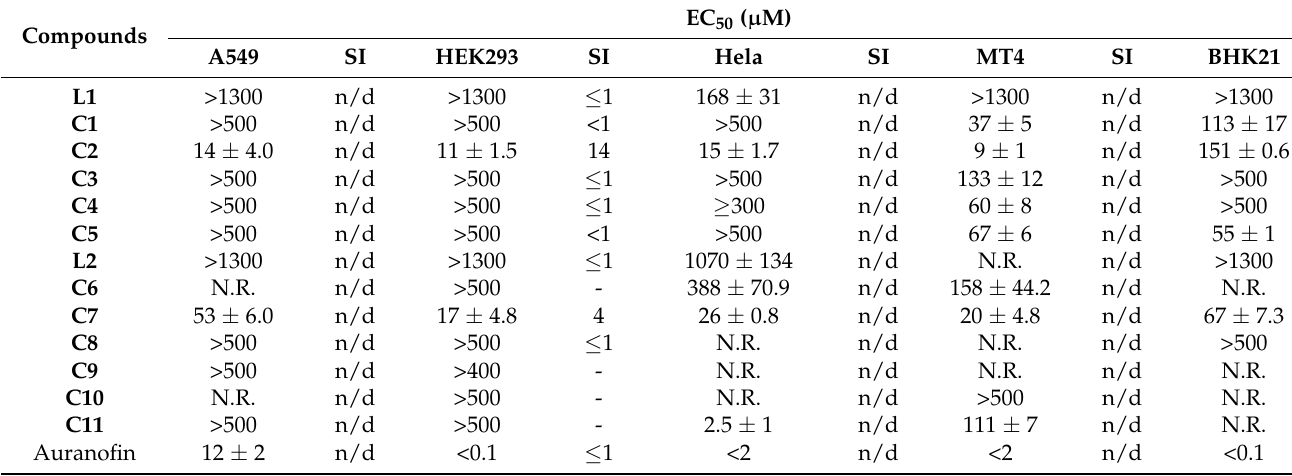
Table 3. Effective concentration (EC 50 ) of compounds against normal kidney cells (BHK21), lung cancer cells (A549), kidney cancer cells (HEK293), cervical cancer cells (Hela), and Lymphoma cells